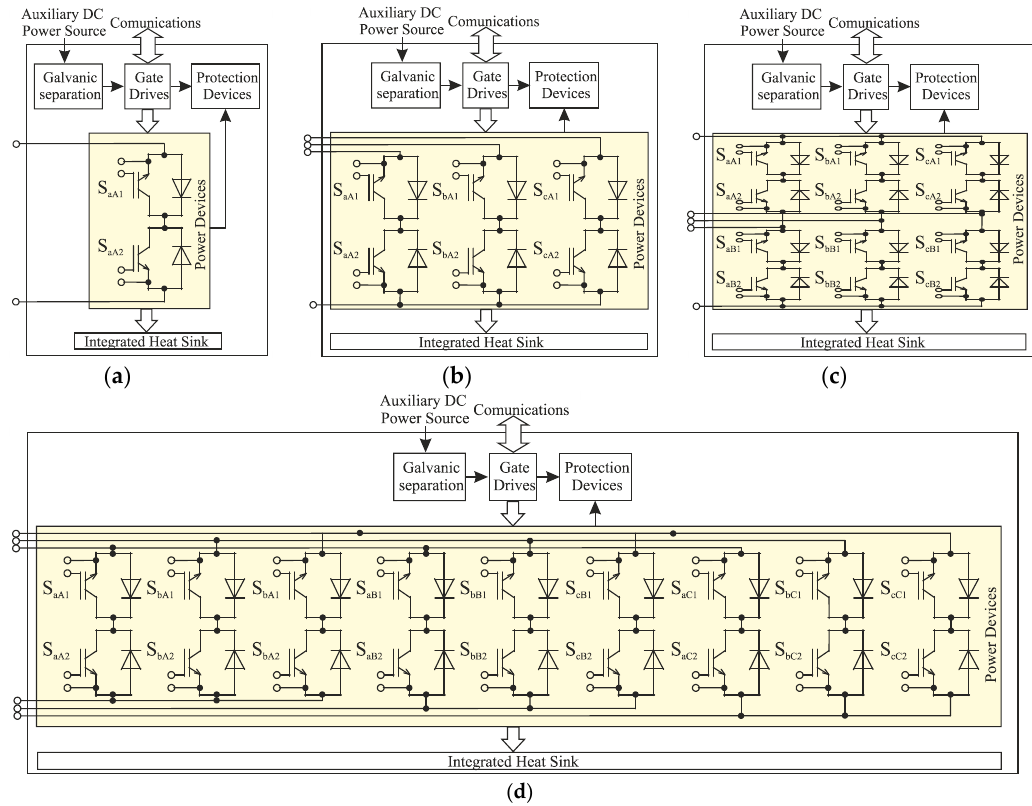
Figure 15. Common switching structures for power-electronic building blocks (PEBBs) in AC/AC power converters ( a ) single bidirectional switch structure, ( b ) single output phase of MC switch configuration, ( c ) two phase of MC switch configuration, ( d ) three phase of MC switch configuration.